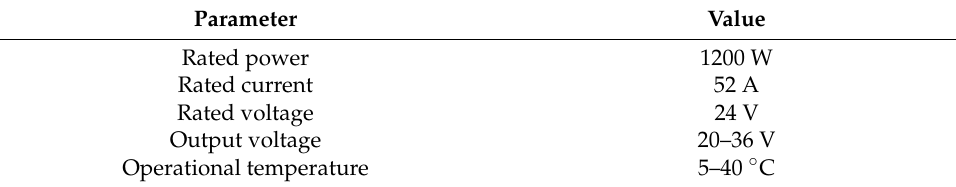
Table 3. Parameters of the fuel-cell power module.